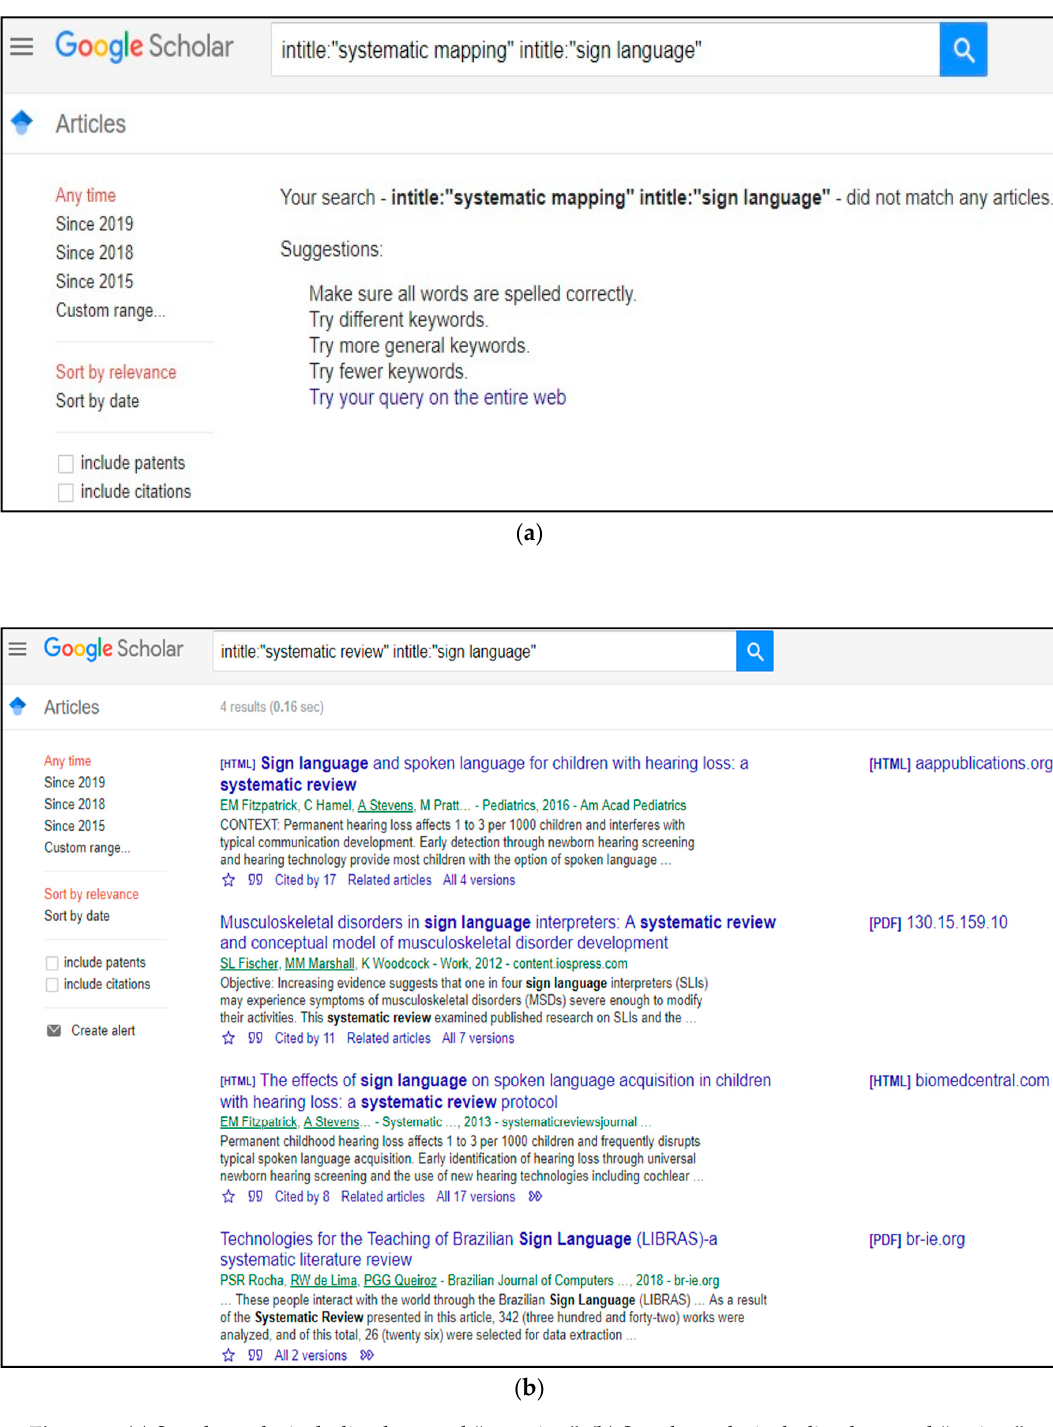
Figure 1. ( a ) Search results including keyword “mapping”; ( b ) Search results including keyword